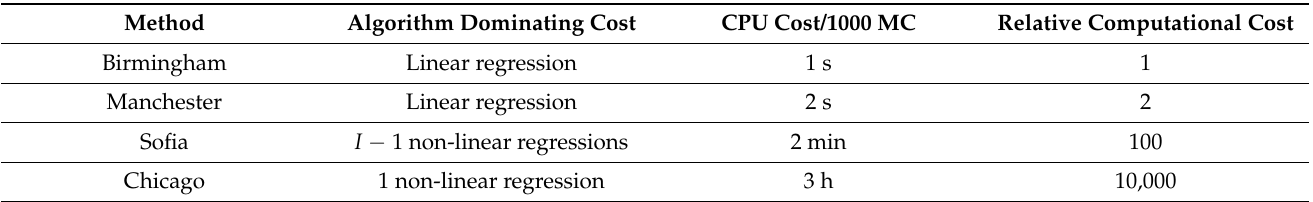
Table 5. Computational cost across the four evaluating an experiment with the methods *. Method Algorithm Dominating